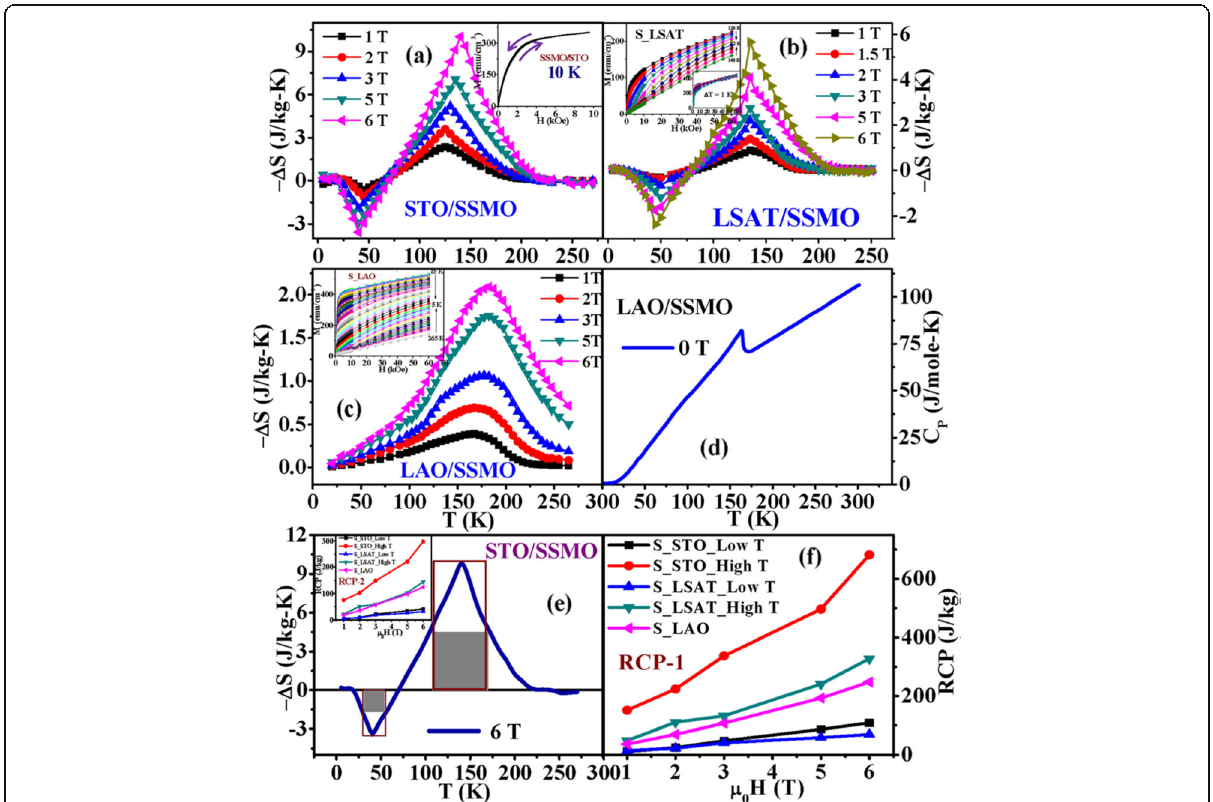
Fig. 36 a – c Temperature dependent| Δ S M | at different magnetic field calculated from M – H data for the SSMO/STO, SSMO/LSAT, and SSMO/LAO films, respectively. Inset of ( b ) and its inset shows the one cycle M – H curves of the SSMO/LSAT film in the temperature interval of 2 K and 1 K, respectively. Inset of ( c ) shows one cycle M – H curves of the SSMO/LAO films in the temperature interval of 5 K. d C P (T) of the SSMO/LAO film at μ Δ S M vs. T curve of the SSMO/STO film at μ 0 H = 0 T. e The 0 H = 6 T. The bigger rectangular sketch and shaded area corresponds to RCP-1 and RCP-2, respectively. Inset shows the value of RCP-2 as a function of magnetic field for three different films. f The value of RCP-1 as a function of magnetic field for three different films. Sm 0.55 Sr 0.45 MnO 3 (SSMO) thin films deposited on LaAlO 3 (LAO), SrTiO 3 (STO), and (La 0.18 Sr 0.82 )(Al 0.59 Ta 0.41 )O 3 (LSAT) single crystalline substrates are named as SSMO/STO, SSMO/LSAT, and SSMO/LAO, respectively. Reproduced with permission of